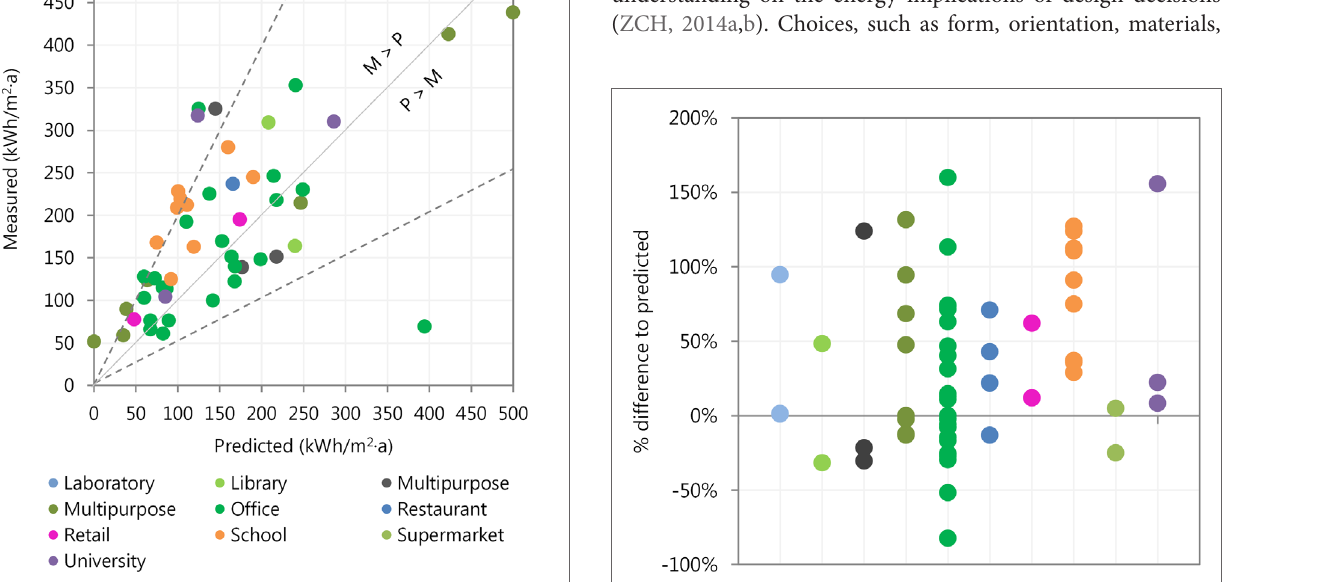
FiGURe 3 | Difference in percentages of measured to predicted energy use of reviewed case studies for different building